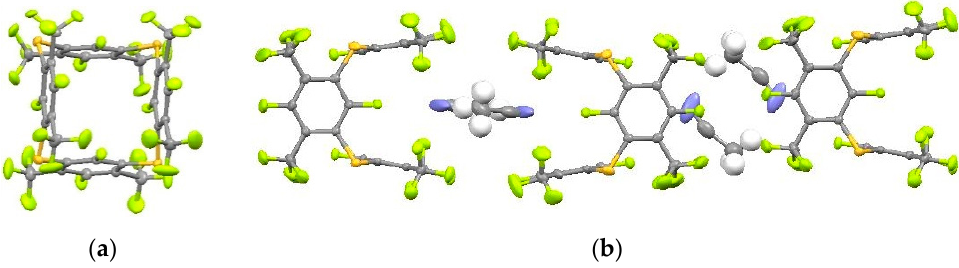
Figure 1. Molecular structure of tetrathiacalixarene 1 ( a ) and complex 1 *2CH 3 CN ( b ).